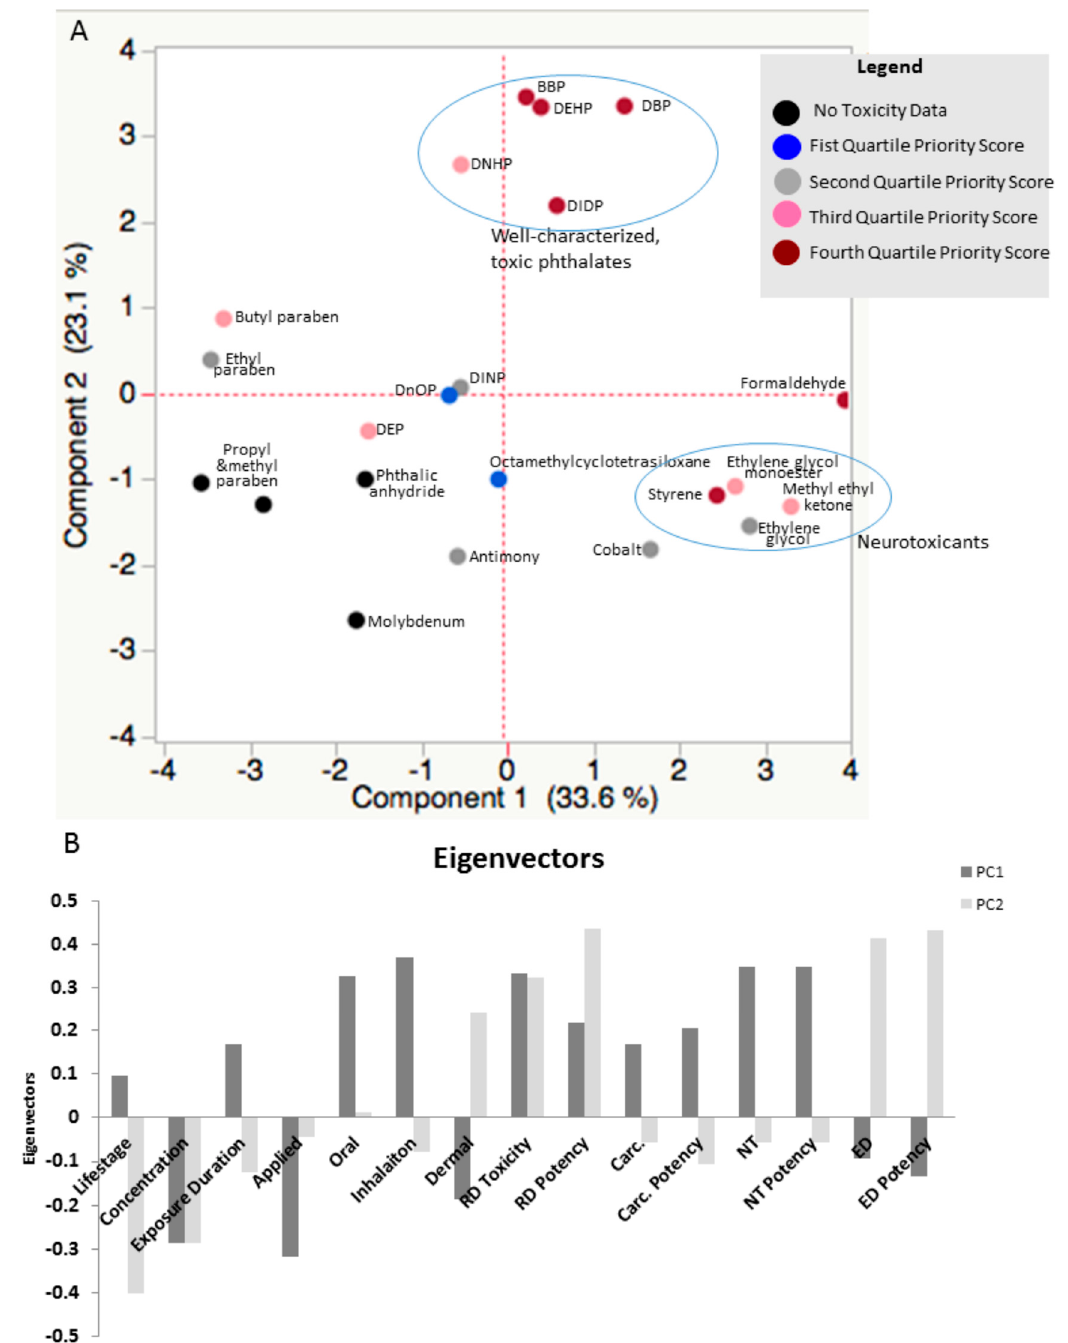
Figure 2 Figure 2. Principal Components Analysis score plot ( A ) and eigenvector plot ( B ) for variables in the CSPA framework. The first two principal components explain ~56% of the variability in total priority index between chemicals. A positive value in the score plot shown in Figure 2A for PC1 is associated with elevated concern over reproductive and developmental toxicity (RD), carcinogenicity (Carc.) and neurotoxicity (NT) and an absence or lesser concern about endocrine disruption (ED) as assessed by toxicity scores for each endpoint (shown in Figure 2B). A positive value in the score plot for PC2 indicates greater concern over reproductive and developmental toxicity, and endocrine effects, as well as an absence or lesser concern over carcinogenicity. Chemicals that cluster together share toxicities. For example, organic solvents such as methyl ethyl ketone and ethylene glycol, cluster with other known neurotoxicants, such as styrene. Phthalates that are well-characterized endocrine disruptors and reproductive and developmental toxicants cluster together as